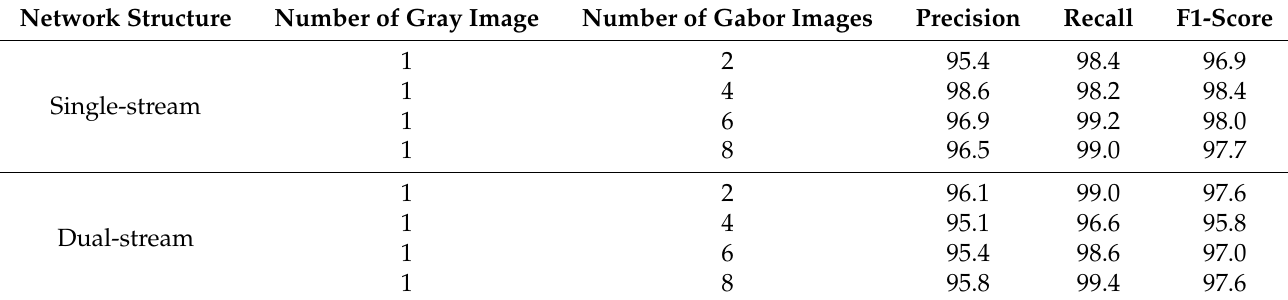
Table 8. Performance according to the number of gabor images on magnetic tile dataset. Network Structure